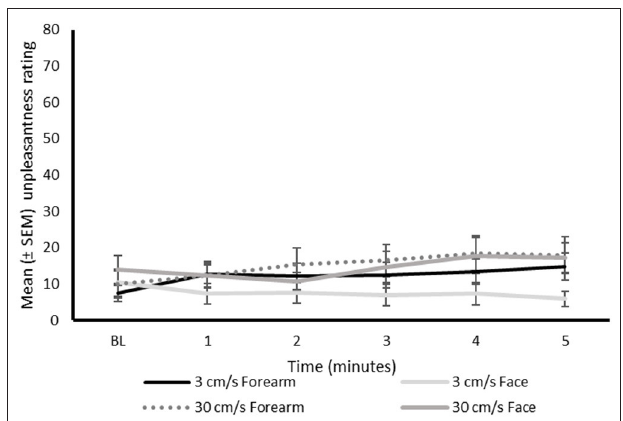
FIGURE 4 | Mean pleasantness ratings (0–100 NRS) during continuous stroking on the differing regions at the differing time intervals. BL, baseline; NRS, numerical rating scale.